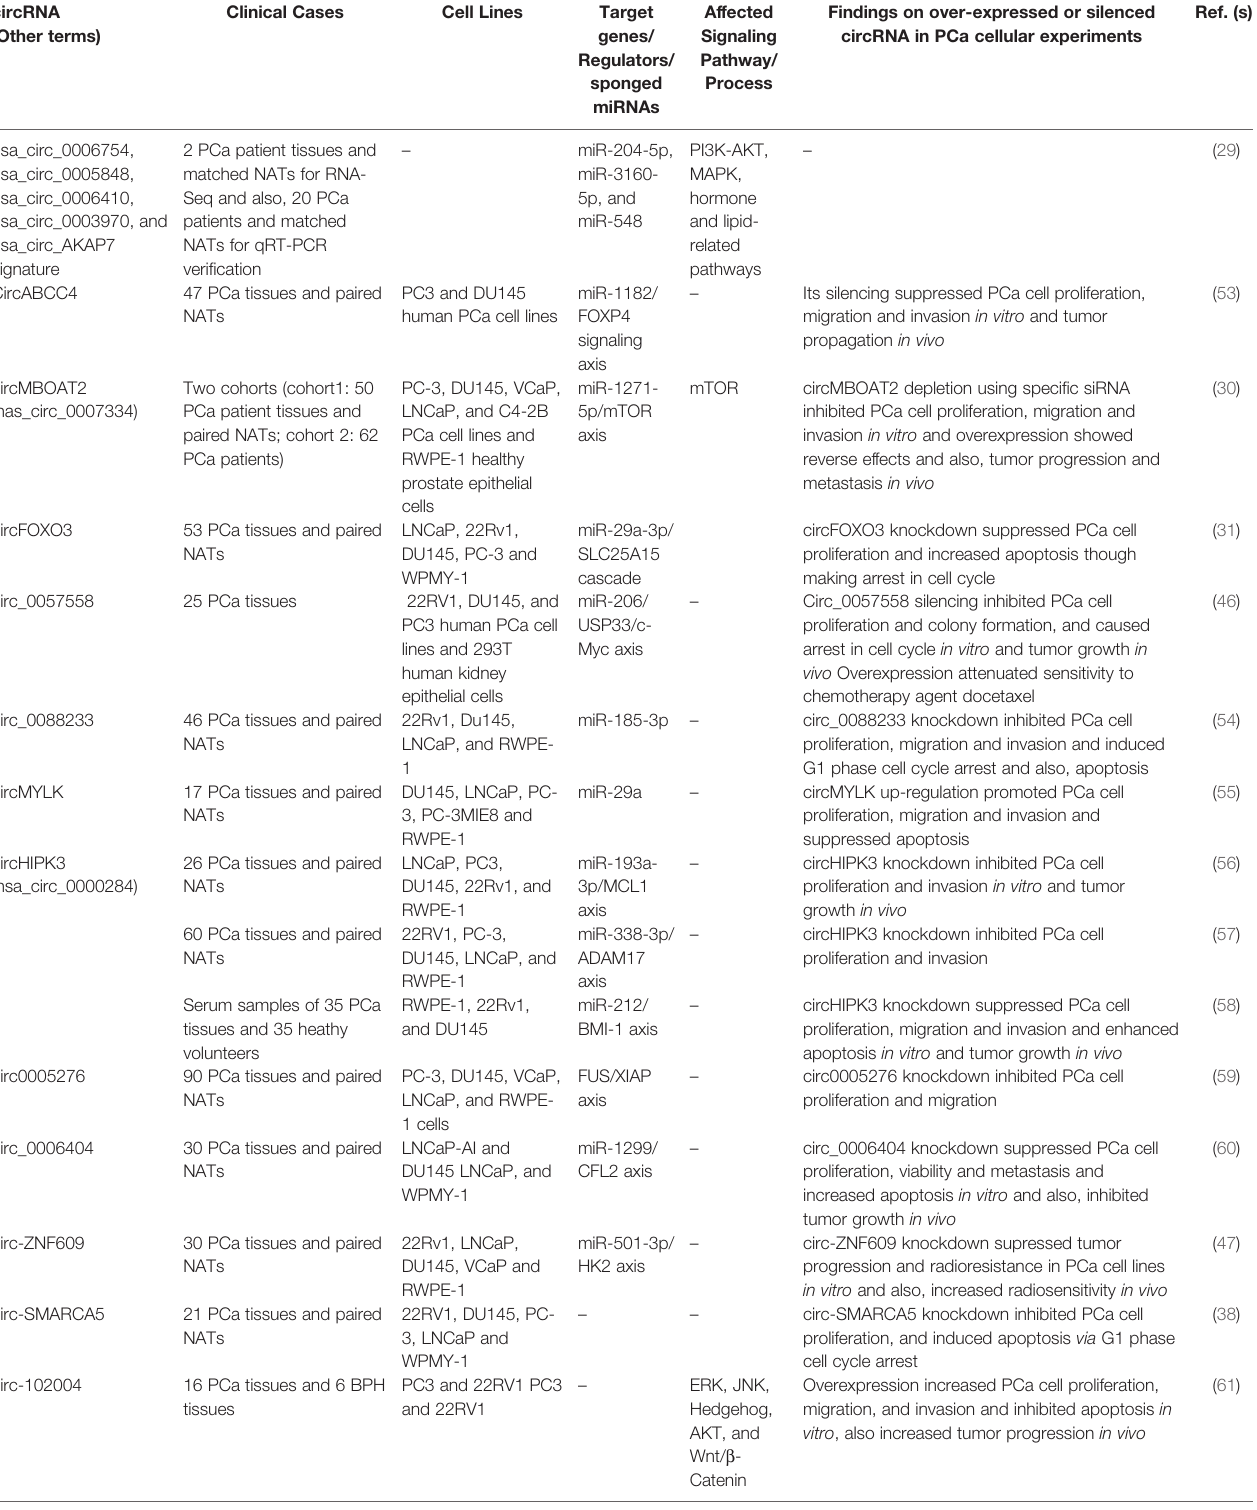
TABLE 1 | Up-regulated circRNAs in